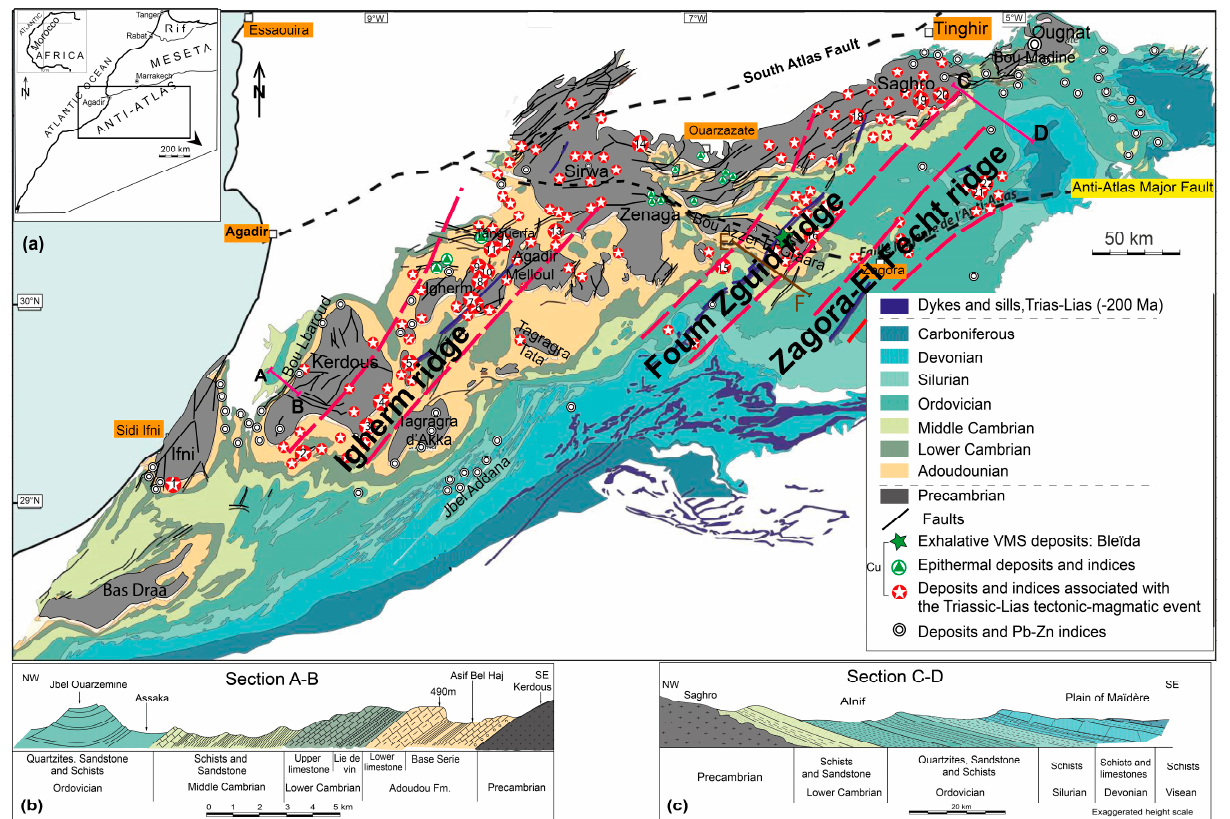
Figure 1. ( a ) Anti-Atlas geological map and coordinates of the most important copper deposits: (1) Jbel Jouad, (2) Ouansimi, (3) Agjgal, (4) Tasrirt, (5) Tazalaght, (6) Imi n’Ifri, (7) Talat n’Ouamane, (8) Tadenst, (9) Tizert, (10) Tiferki, (11) Amadouz, (12) Tazert, (13) Tirzit, (14) Tidzi, (15) Jbel N’Zourk, (16) Jbel Laassel, (17) Timarighine, (18) Bou Skour, (19) Asfalou, (20) Akka n’Oulili, (21) Oumjrane-Bou n’Hass, (22) Inset to the top left is a sketch of the Anti-Atlas situation. ( b ) Geological cross-section A-B (modified from Choubert [25]). ( c ) Geological cross-section C-D (modified from Abia et al. [26]) (geological cross-section locations are indicated on the map).